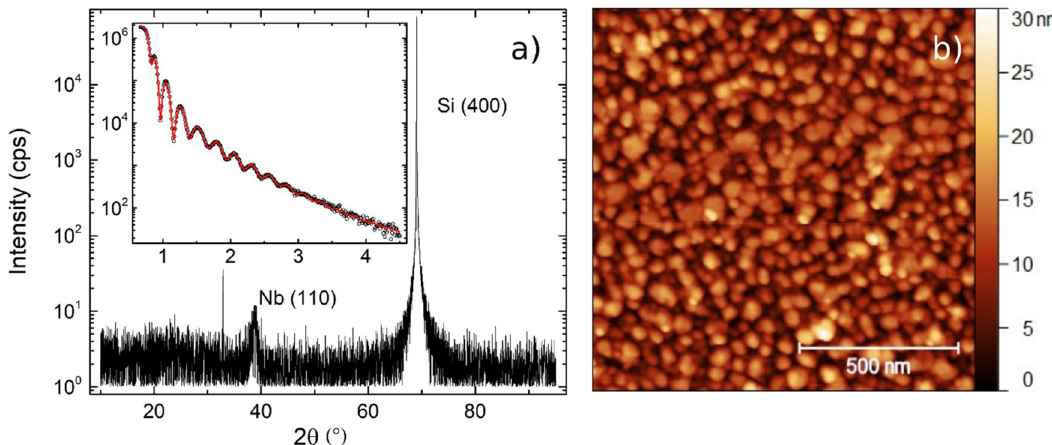
Figure 1. ( a ) XRD spectra of a thin film sample, with Nb (110) and Si substrate (400) peaks identified. Inset shows an XRR scan for the same sample. The solid red line is a fit to the data. ( b ) AFM image of the same Nb(30)/AlO x (3) thin